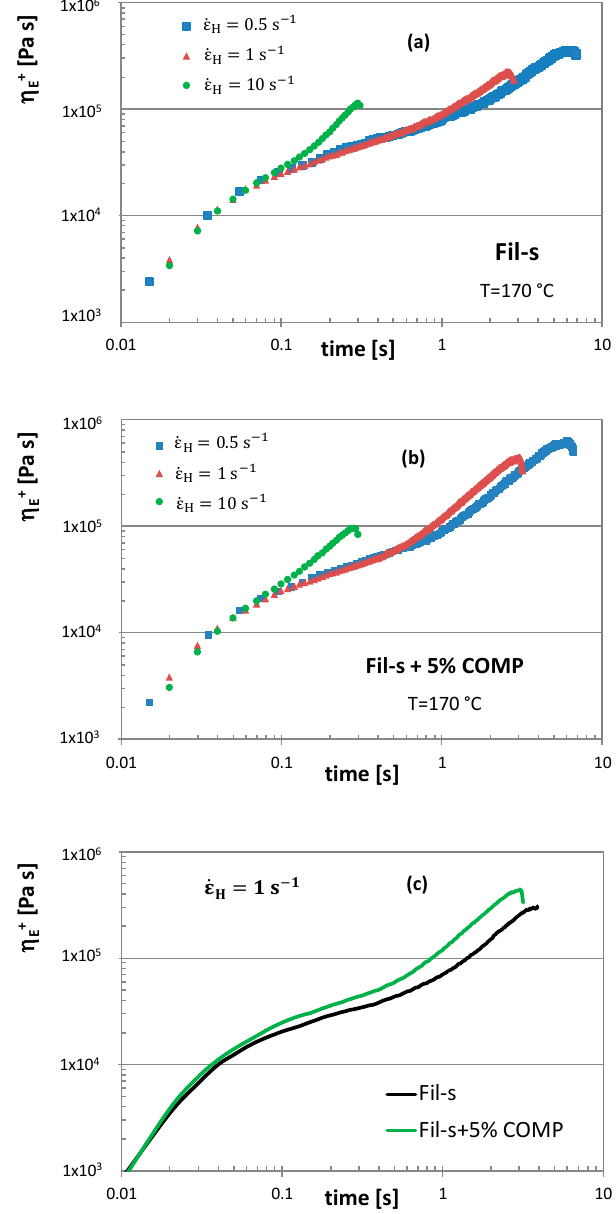
Figure 6. The tensile stress growth coefficient, η E+ , as a function of time at 170 ◦ C and at various Hencky strain rates, 𝜺(cid:4662) 𝑯 , for: ( a ) neat Fil-s, ( b ) compatibilized Fil-s and ( c ) both samples at 𝜺(cid:4662) 𝑯 = 1 s − 1 .